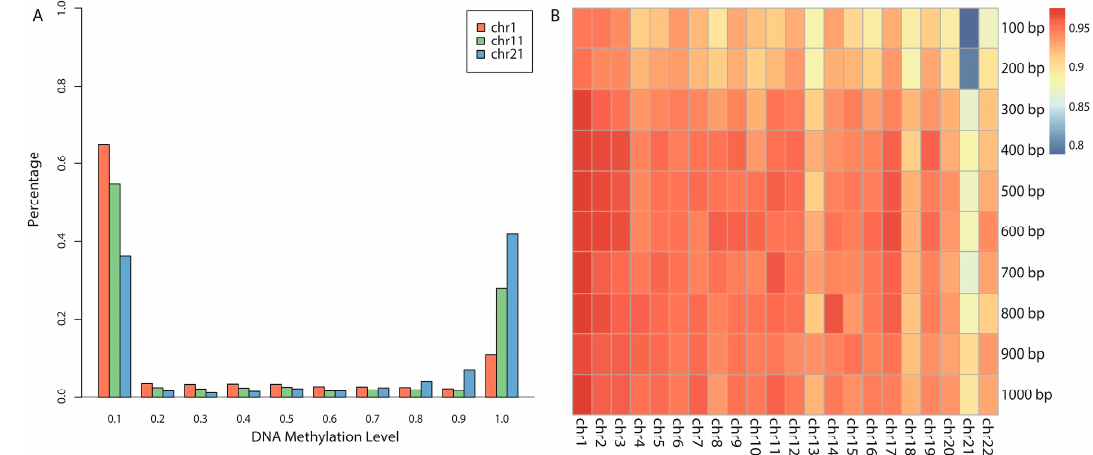
Figure 1. DNA methylation patterns and the heat map of overall prediction accuracies: ( A ) bimodal distributions of DNA methylation patterns; and ( B ) the heat map of prediction results for combinations of different chromosomes and different window sizes.